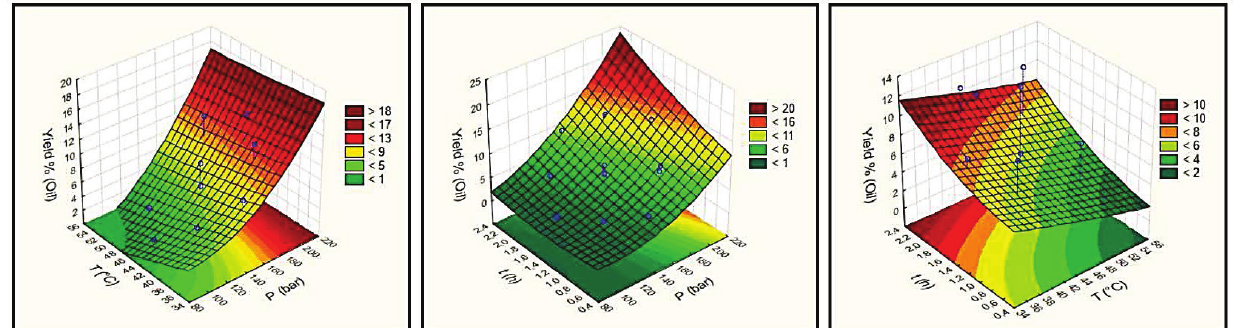
Fig. 3 – Extracted mass (Y% exp) surfaces response